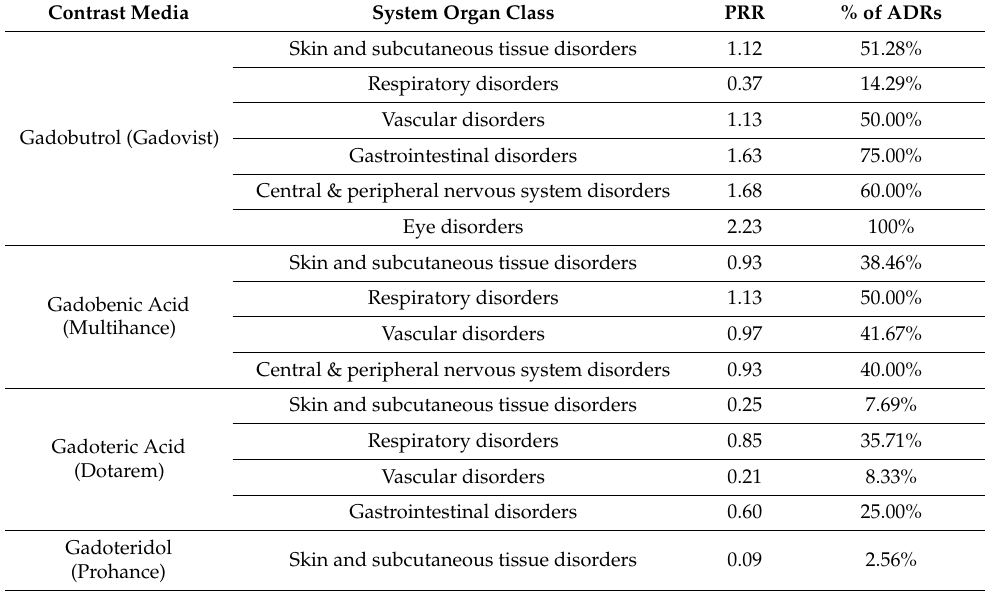
Table 4. Proportional reporting ratio of gadolinium-based contrast